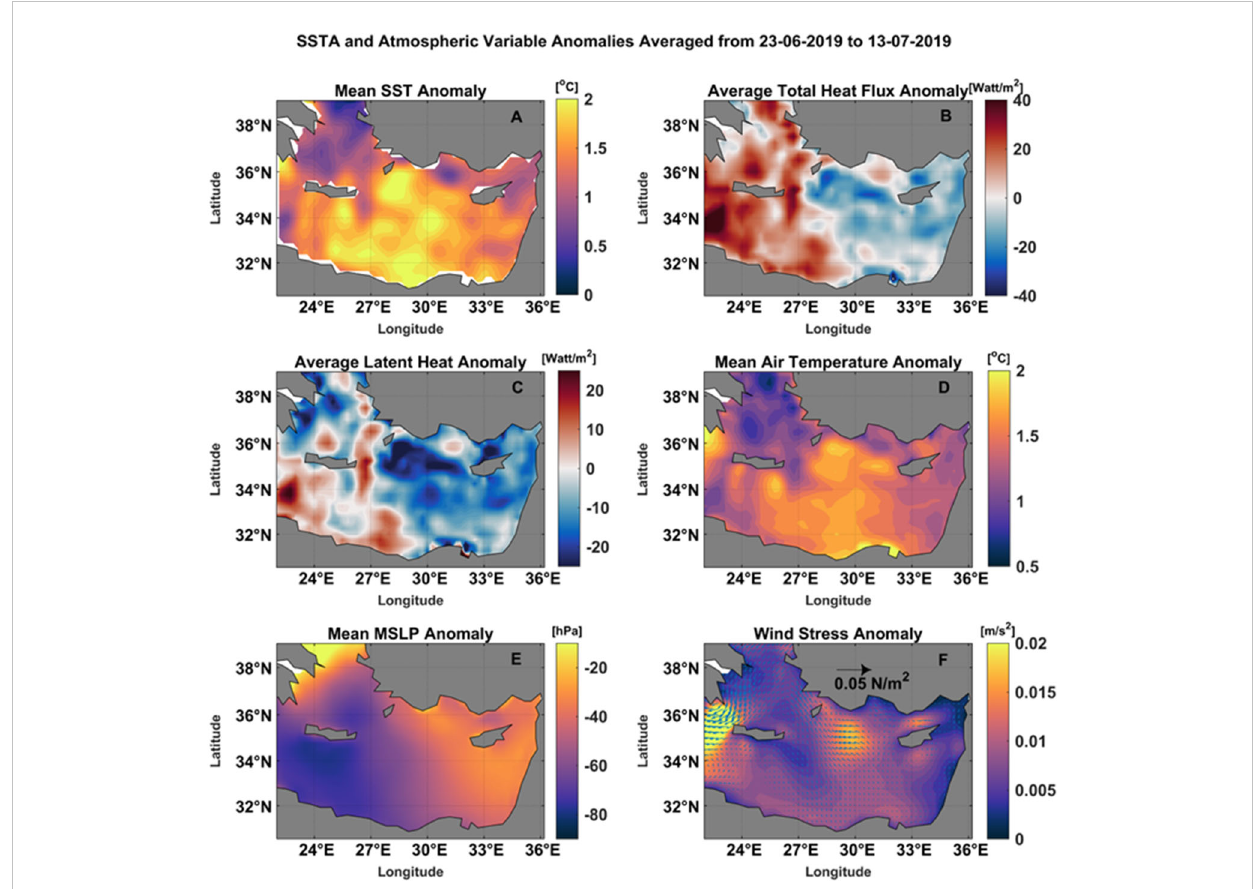
FIGURE 11 The mean (A) SST anomaly [°C], (B) total heat fl ux anomaly [W/m 2 ], (C) latent heat fl ux anomaly [W/m 2 ], (D) air temperature anomaly [°C], (E) mean sea level pressure anomaly [hPa], and (F) wind stress anomaly [N/m 2 ] during the MHW event (23 June-13 July 2019) in the EMB. Note that the anomalies were calculated based on 1982-2020 climatology from ERA5 hourly data.